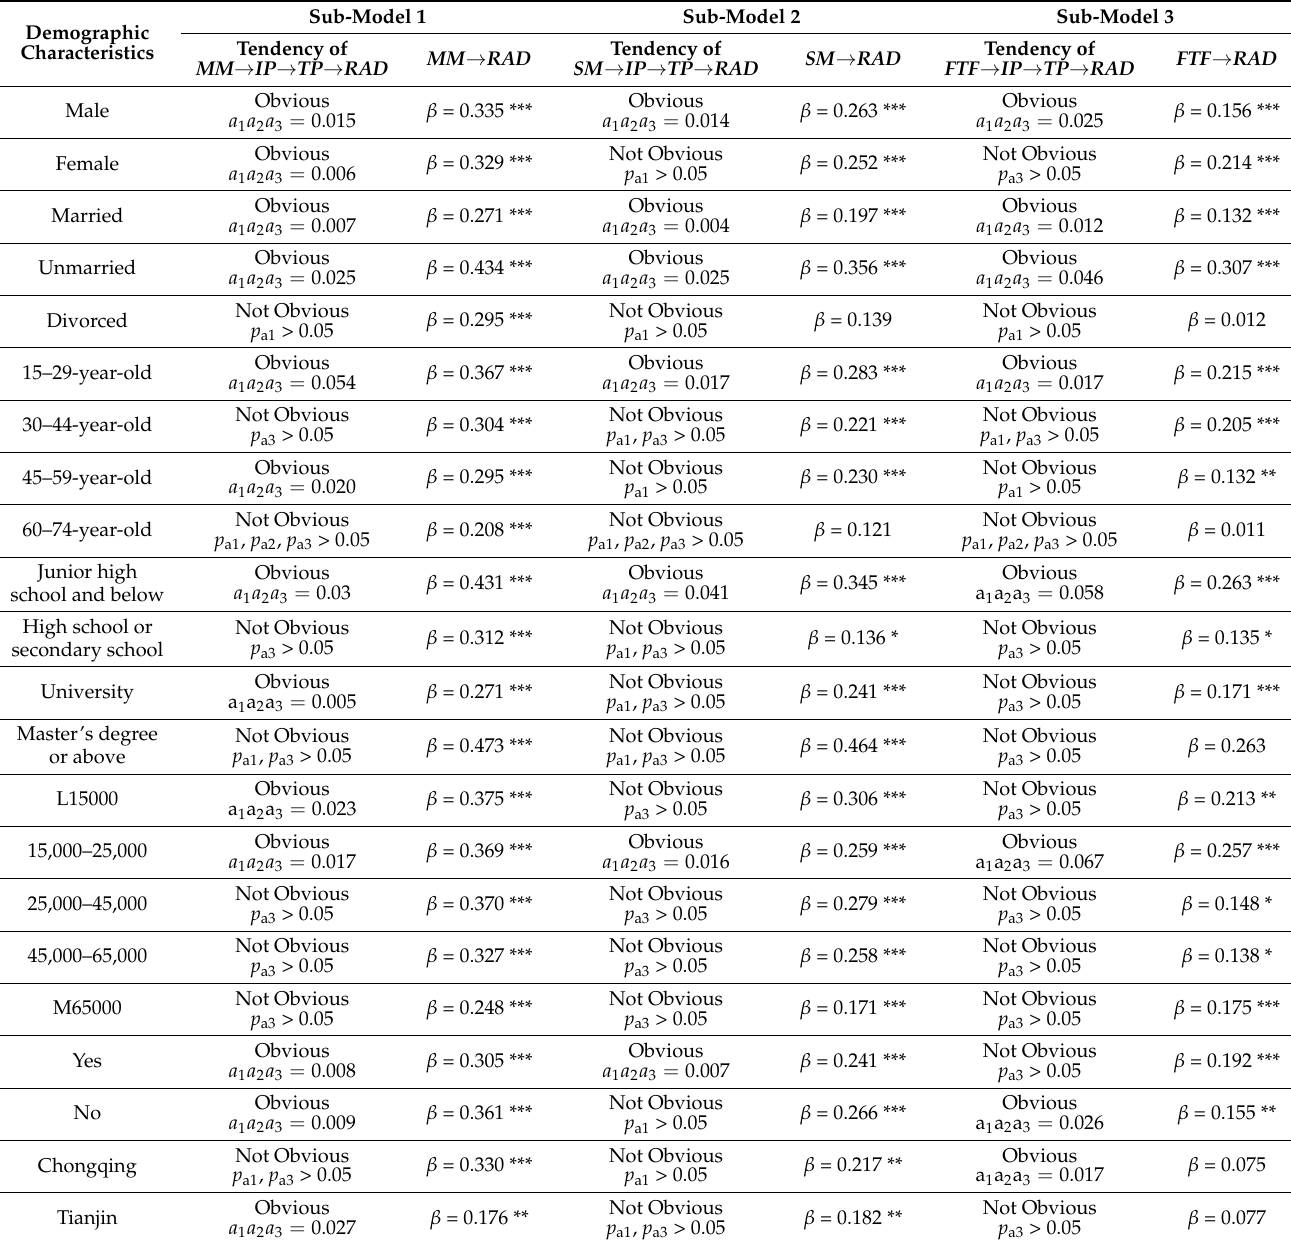
Table 8. Channel preference comprehensive analysis of sub-models